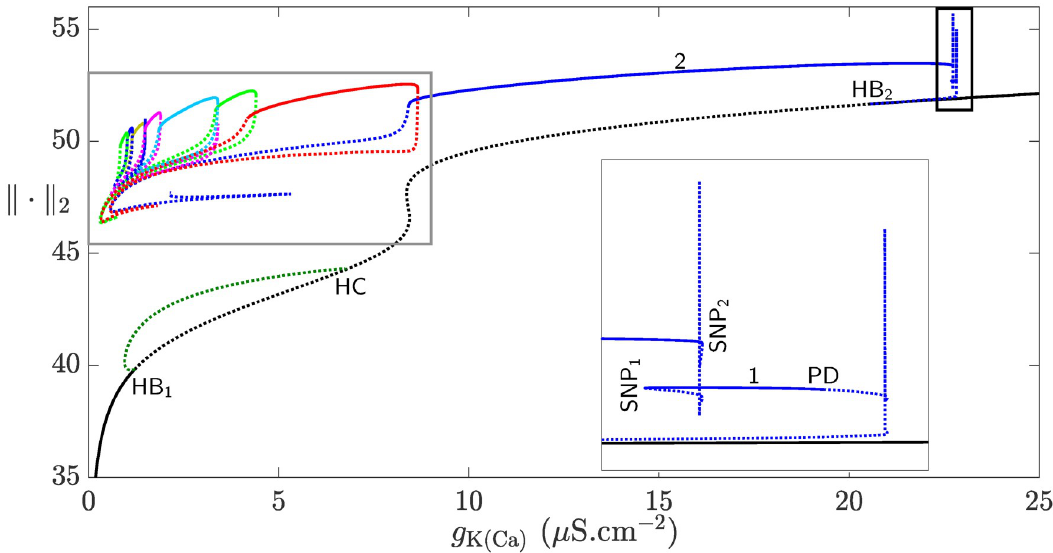
Fig 7. The effects of g K(Ca) on the dynamics of the full system (1). Bifurcation diagram of the full system (1) with respect to g K(Ca) using the L 2 -norm of the state variables. Two subcritical Hopf bifurcations HB 1 and HB 2 are present along the branch of equilibria (black). The equilibria are unstable (dotted) between HB 1 and HB 2 and stable otherwise (solid). The envelope of periodic orbits emanating from HB 1 (olive) is unstable and terminates at a homoclinic bifurcation, denoted by HC . The family of periodic orbits emanating from HB 2 is unstable. After a drastic change in the L 2 -norm of the state variables, the envelope becomes stable at a period- doubling bifurcation ( PD ). This envelope becomes unstable at a saddle-node bifurcation of periodic orbits ( SNP 1 ) before undergoing the spike-adding process, and then becomes stable again at another saddle-node bifurcation of periodic orbits ( SNP 2 ). The two instances of drastic changes in the L 2 -norm of the state variables inside the right black box are further magnified in the inset. The set of (colored) curves inside the left gray box shows isolas of square-wave BPOs with different number of spikes. These isolas are further magnified in Fig 8 A